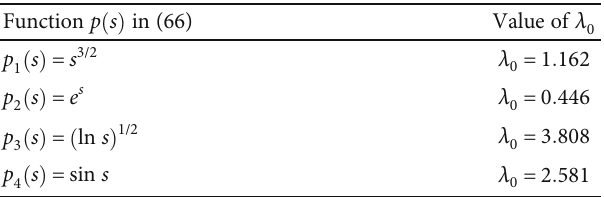
Figure 2: Graph of the functions λ 0